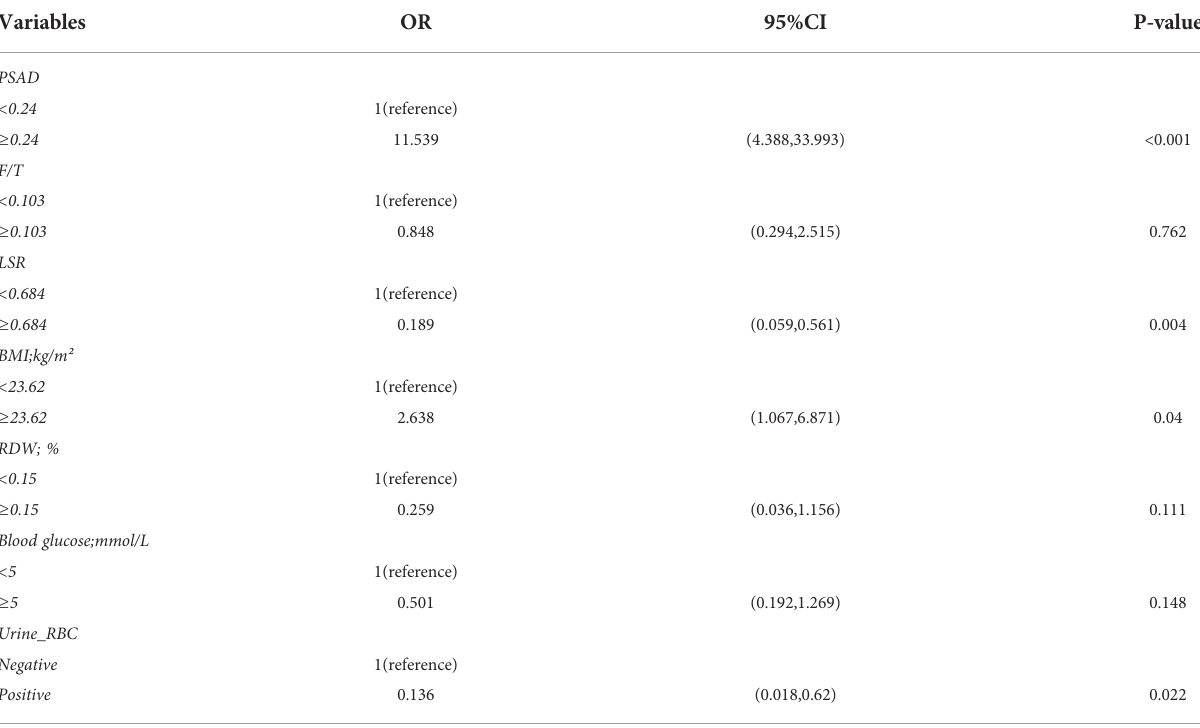
TABLE 3 Multivariate logistic regression in the differential diagnosis of prostate cancer in the whole data cohort.